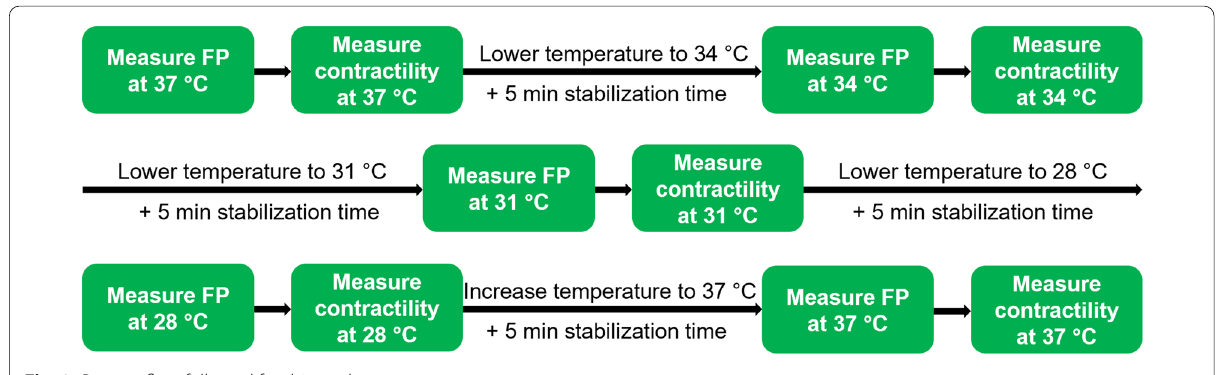
Fig. 2 Process flow followed for this